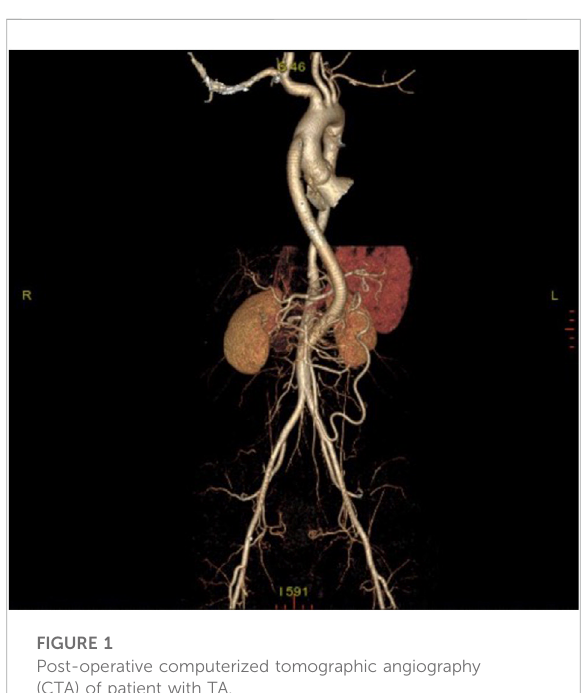
FIGURE 1 Post-operative computerized tomographic angiography (CTA) of patient with